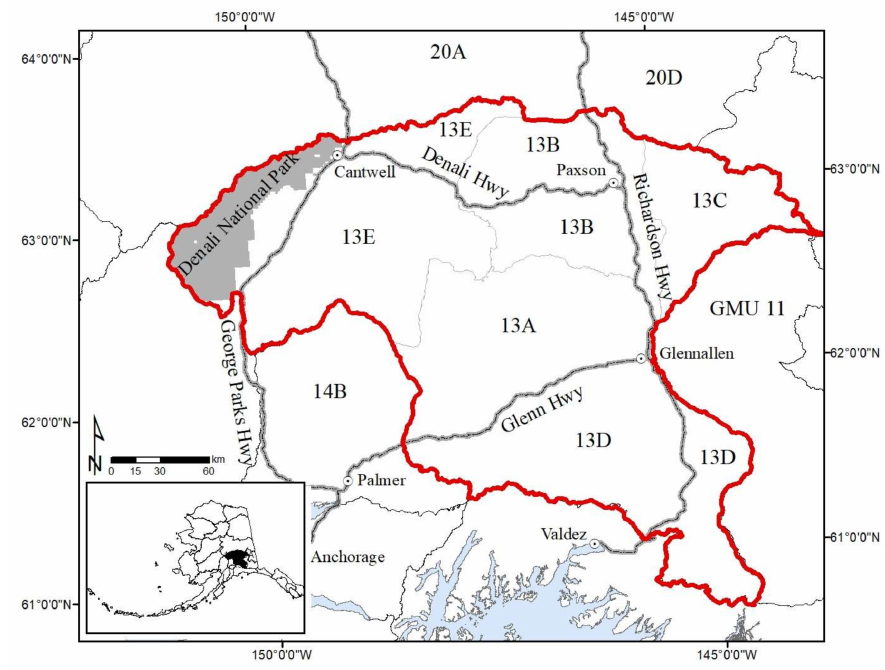
Figure 1. Game Management Unit (GMU) 13 (red outline), including subunits A, B, C, D, and E (grey lines are highways) in south-central Alaska,